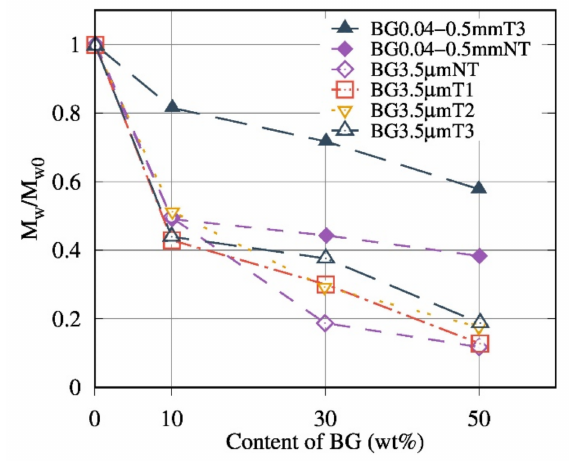
Figure 6. Evolution of the average molecular weight ratios ( M w / M w0 ) as a function of the BG content for composites with various sizes of BG and with various thermal treatments of